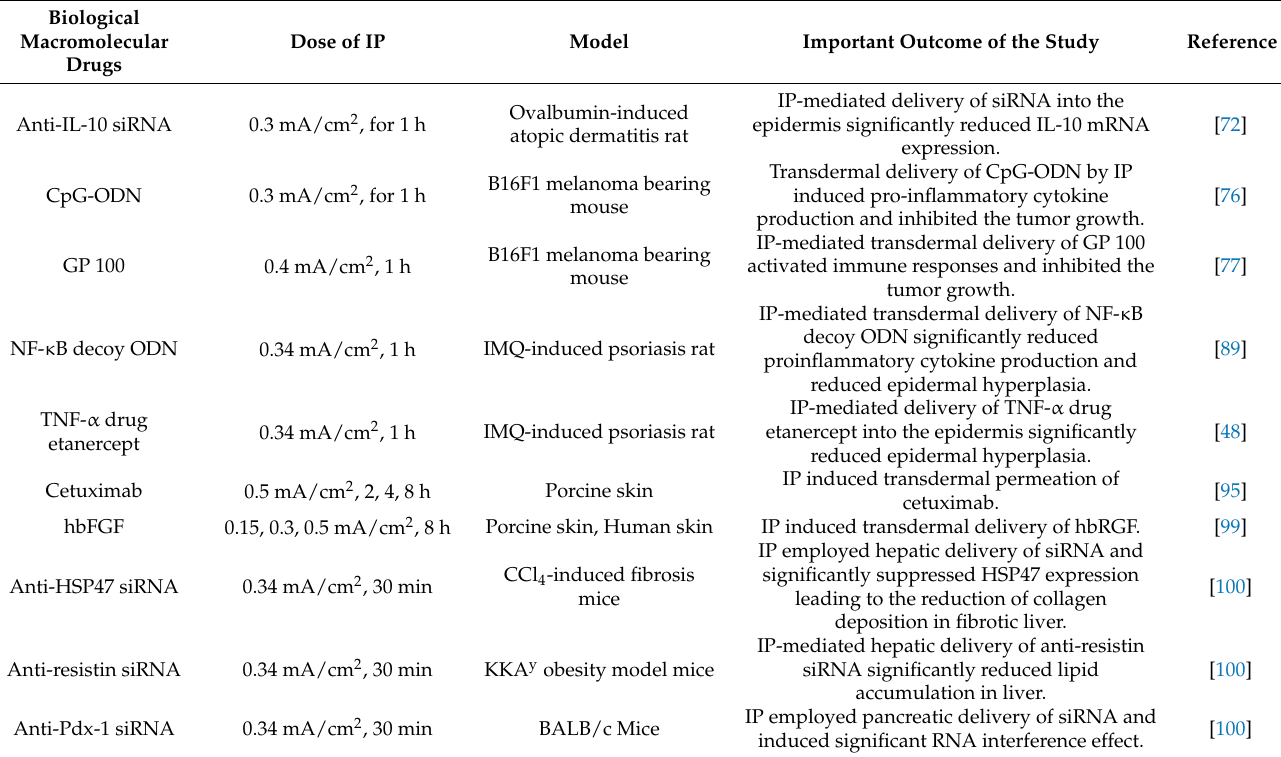
Table 2. A brief explanation of the IP-mediated delivery of biological macromolecular drugs, and the important